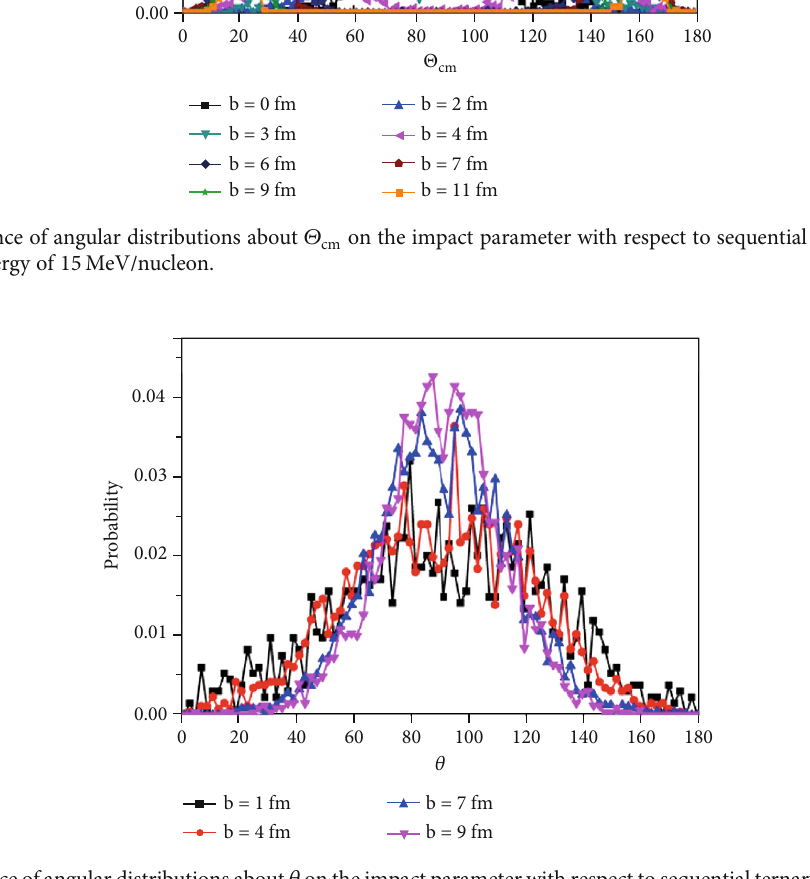
Figure 8: The dependence of angular distributions about θ on the impact parameter with respect to sequential ternary fi ssions in 197 Au+ 197 Au system at an energy of